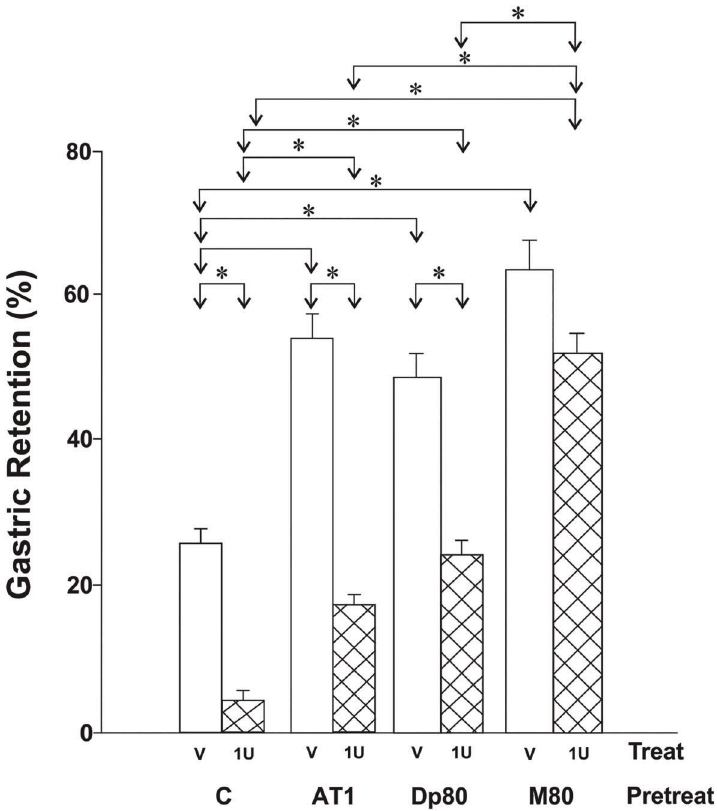
Figure 3. Gastric retention of a saline test meal (2 mL/100 g animal weight), 10 min after admin- istration by gavage to rats. The animals were pretreated (Pretreat) iv with saline (C), 1 mg/kg atropine sulfate (AT1), 80 mg/kg dipyrone (Dp80), or a mixture of 1 mg atropine + 80 mg/kg dipyrone (M80) and, after 30 min, treated (Treat) iv with vehicle (V) or 1 U/kg insulin (1U). The test meal, was administered 30 min after treatment. Data are reported as means ± SE for 10 animals per group. *P o 0.05 (ANOVA followed by Tukey post-test).